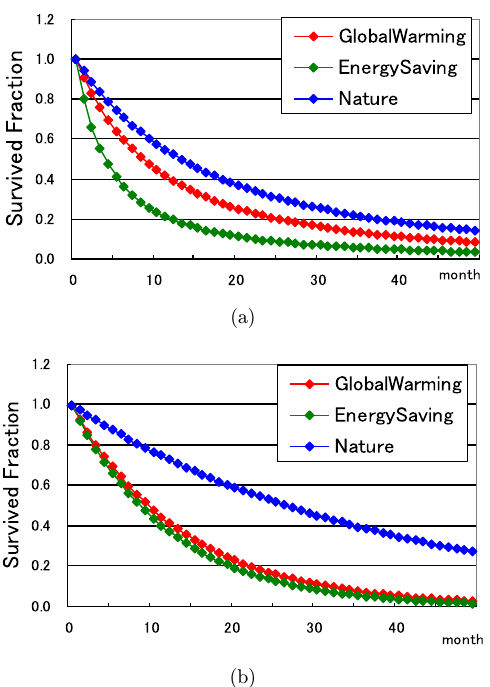
Fig. 5. Survival fraction of memory calculated by using the oblivion functions of (a) the power-law type and (b) the exponential